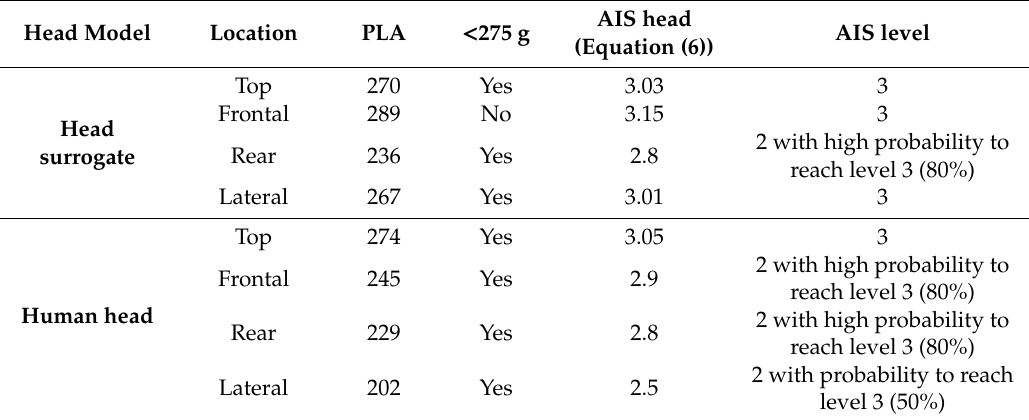
Table 8. Peak linear acceleration (PLA) and AIS for the curbstone anvil